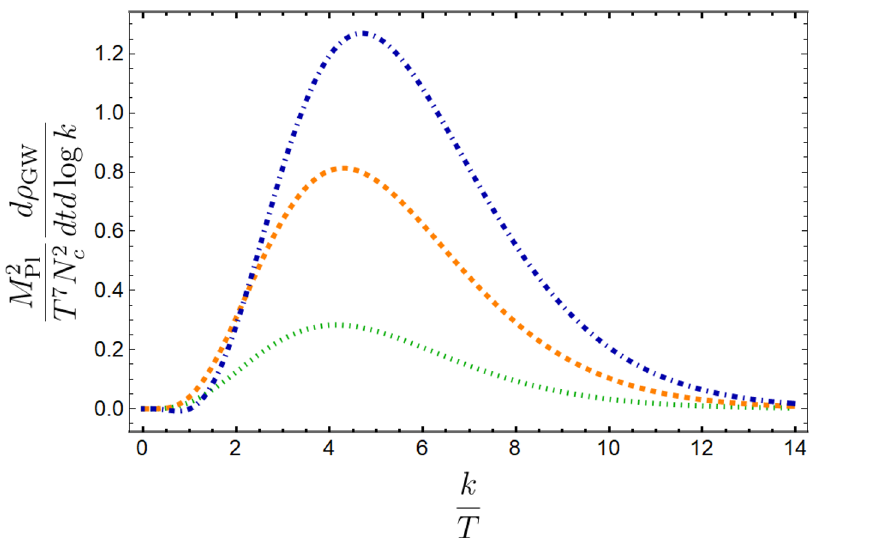
Figure 2 . Comparison between the energy density of gravitational waves produced by quasi-particle excitations in a weakly-coupled thermal plasma for different values of the coupling constant λ . The lines are colored for the values of the wave number in which the computation can be trusted ( ˆ k > 2 λ ). The spectra correspond to λ = 0 . 1 (dotted green), λ = 0 . 5 (dashed orange) and λ = 1 . 8 (dot-dashed blue). The peaks of the spectra can be seen to occur around k ∼ T for different values of λ